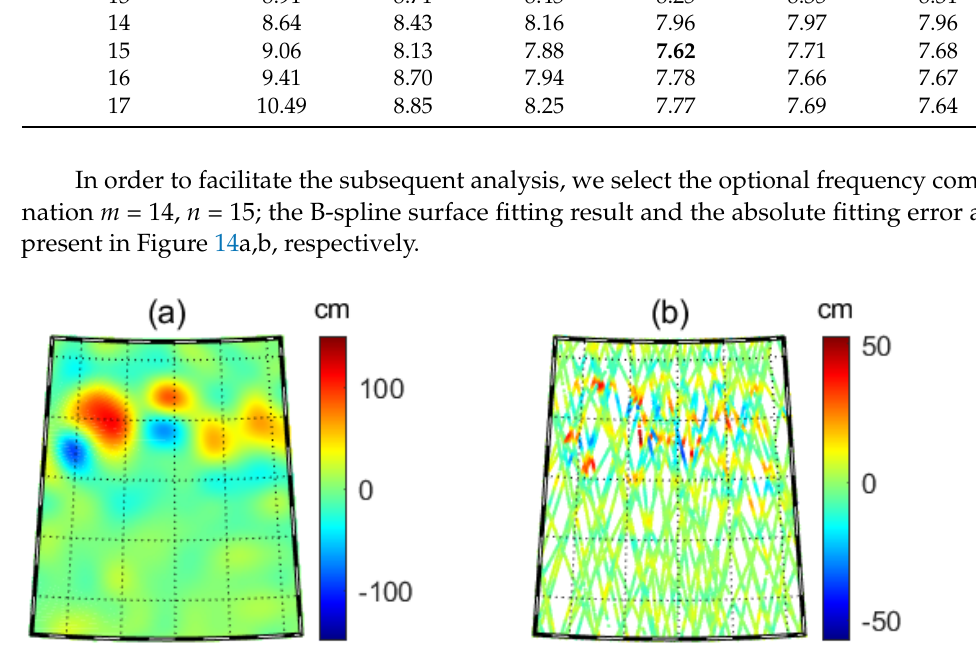
Figure 14. ( a ) The B-spline surface fitting result corresponding to the optional frequency combination. ( b ) The absolute error distribution of along-track data.